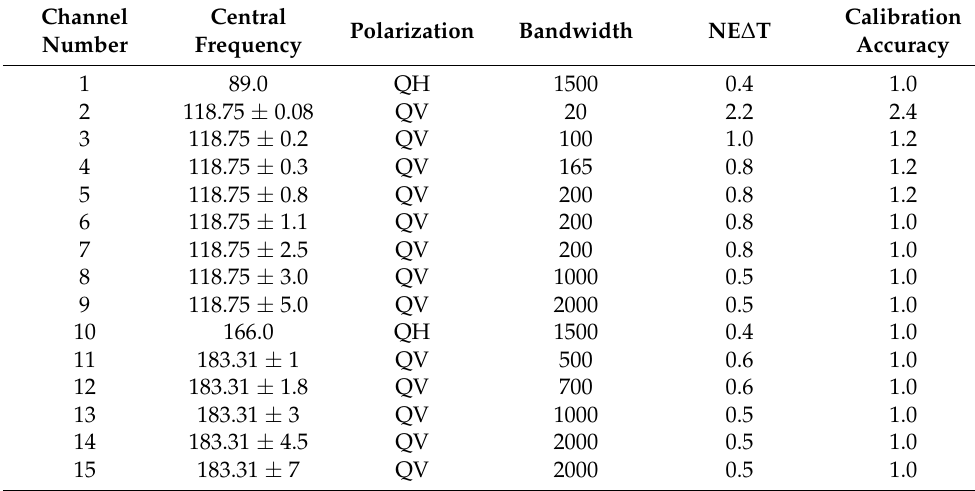
Table 1. Channel number, central frequency (unit: GHz), polarization (QV and QH represent quasi- vertical and quasi-horizontal polarization, respectively), bandwidth (unit: MHz), noise